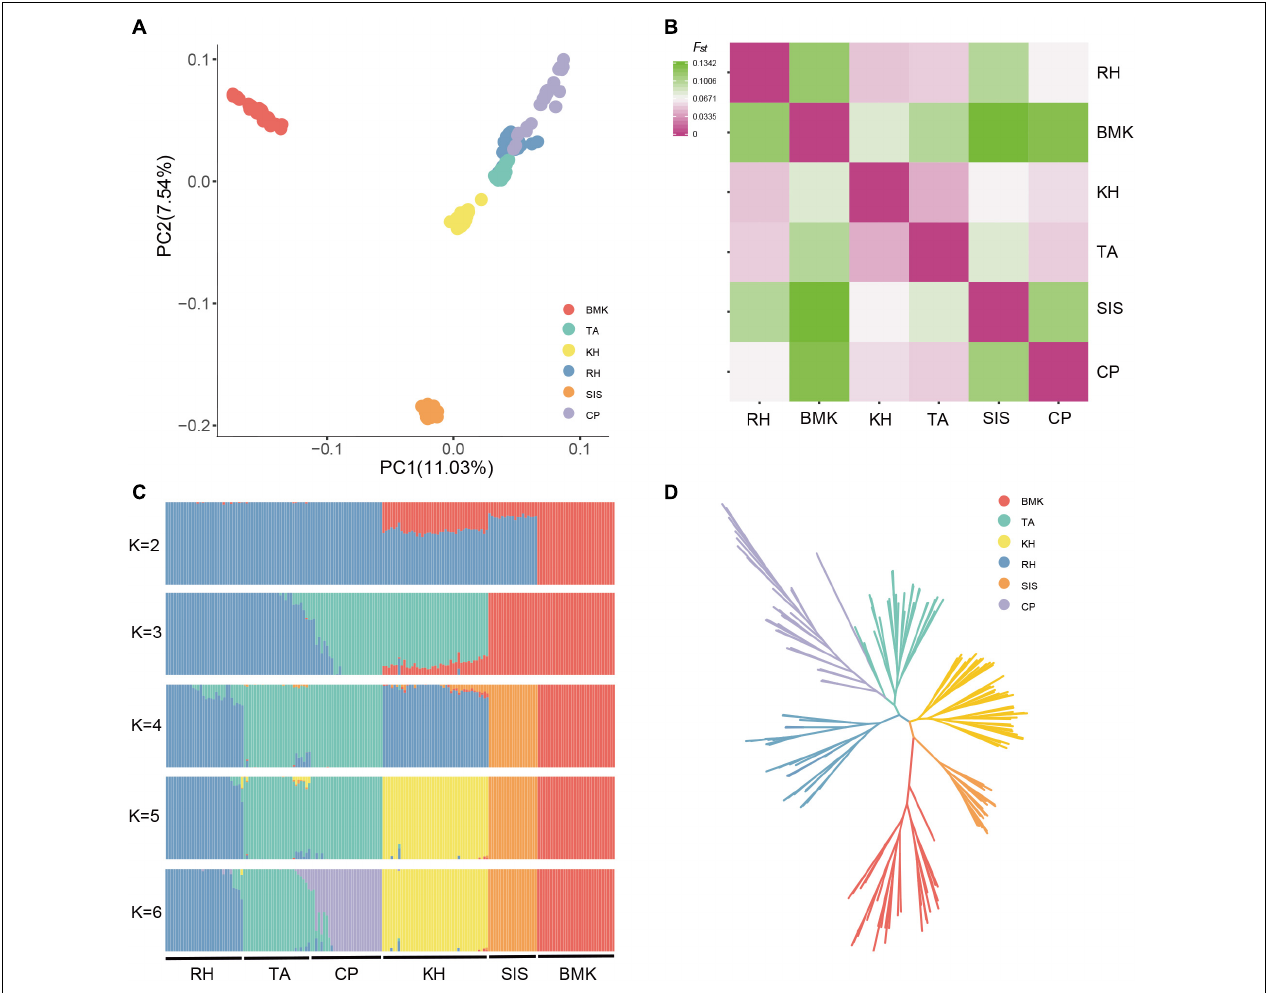
FIGURE 1 | Population structure analysis of the six populations by principal component analysis (PCA) (A) , Pairwise F st distance (B) , ancestral estimation (C) , and phylogenetic inference (D) .